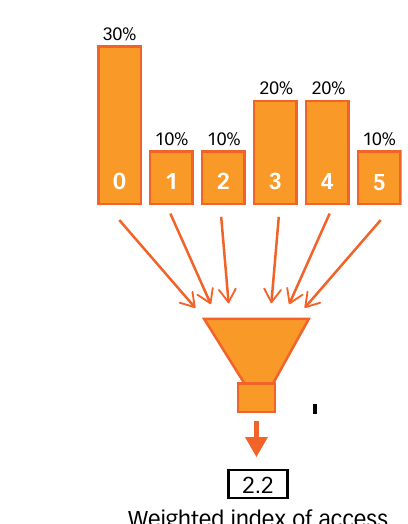
Figure 2. Weighting of tiers to arrive at an index of access to